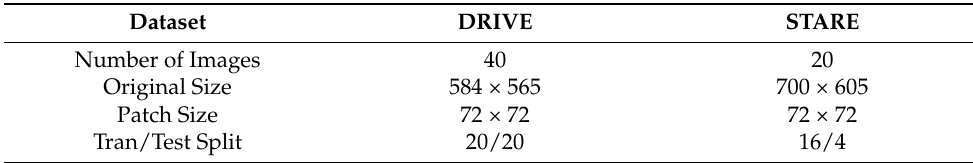
Table 1. Dataset